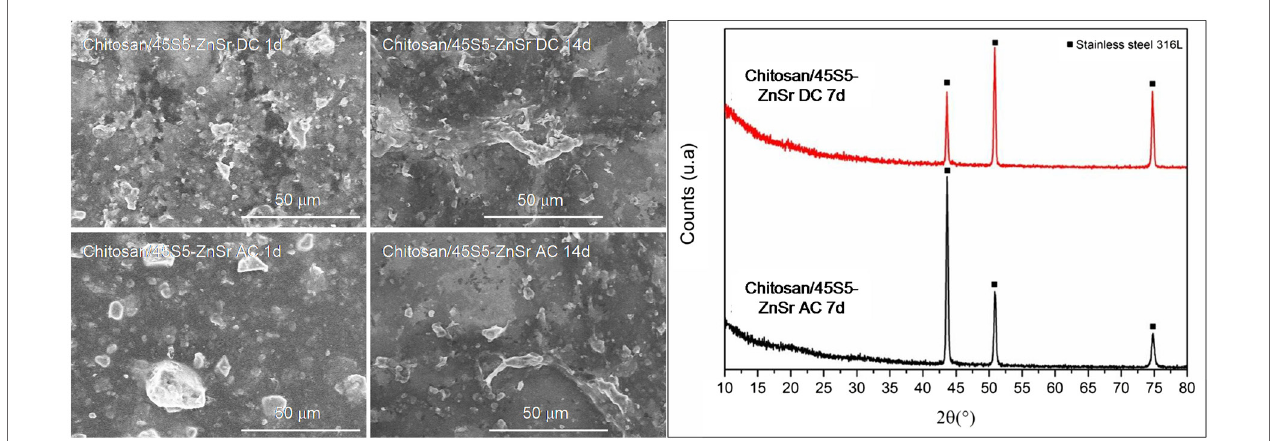
FigUre 12 | seM micrographs and XrD analyses of 45s5-Znsr after immersion in sBF solution